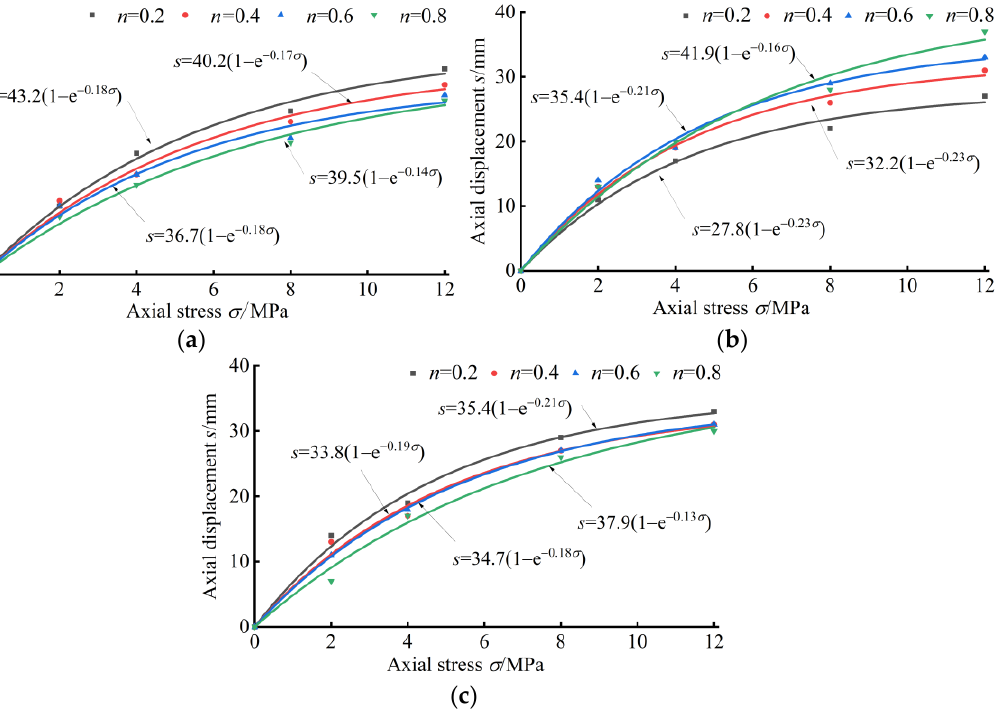
Figure 5. Axial displacement – axial stress curve for broken coal particles. ( a ) Continuous grading structure; ( b ) intermittent 0~5 mm particle size gradation structure; ( c ) intermittent 15 – 20 mm particle size gradation structure.